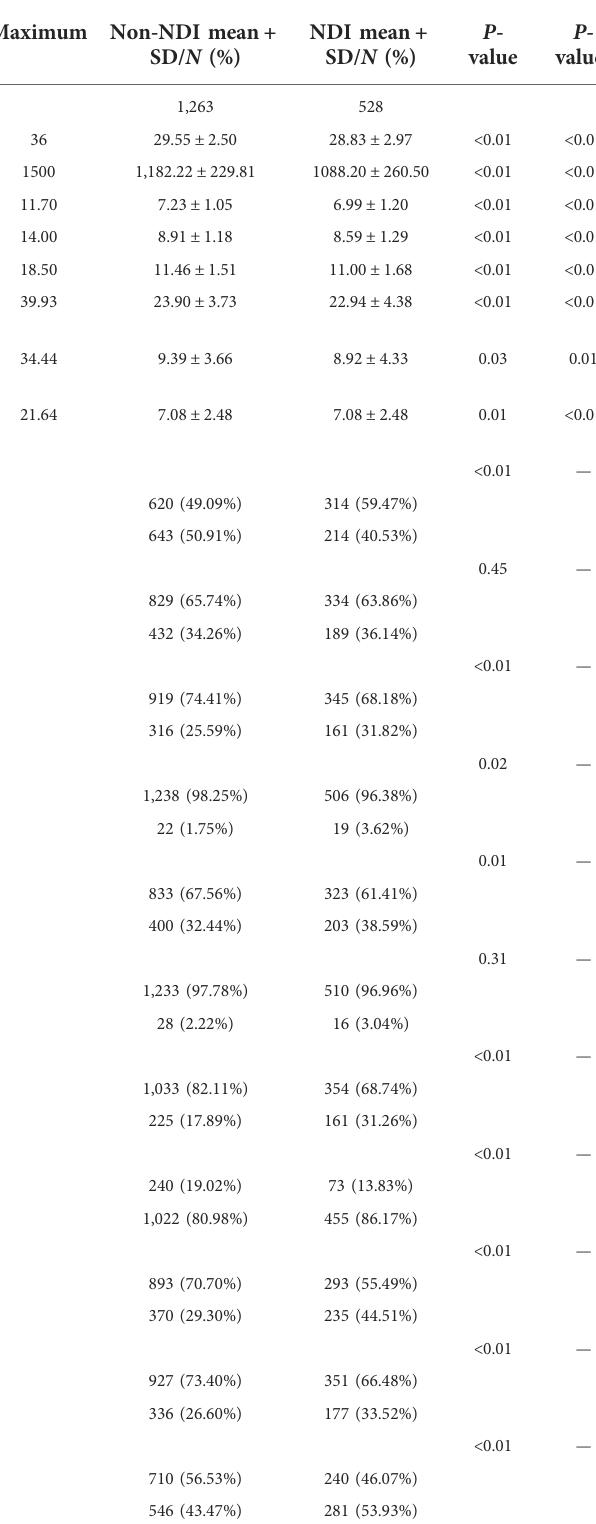
TABLE 1 Baseline characteristics of